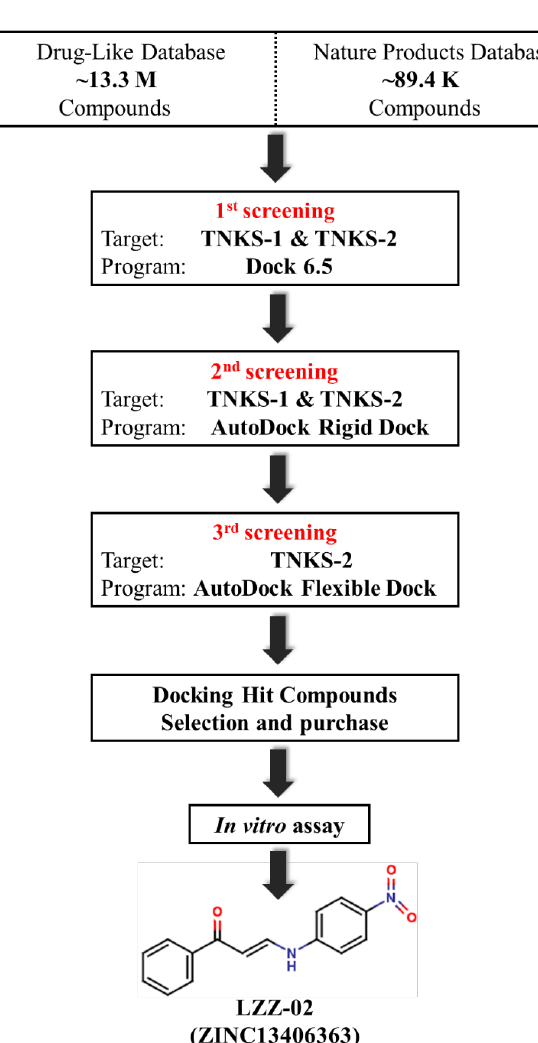
Figure 2. General workflow for the discovery of the TNKS-1/2 inhibitor.